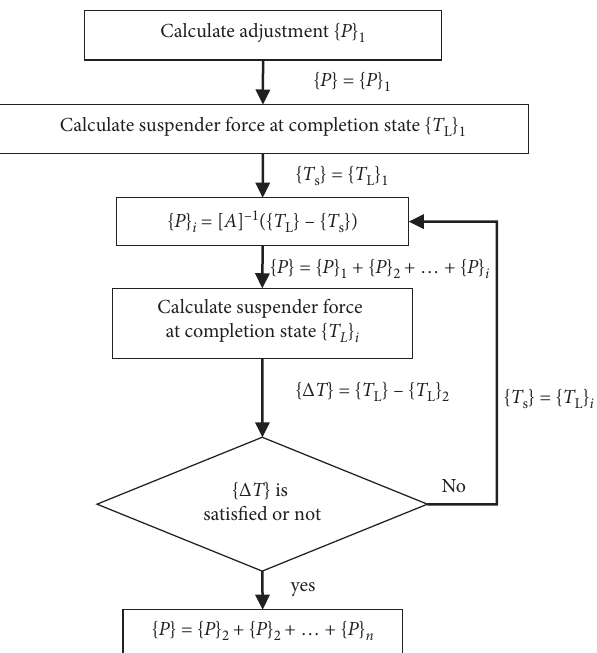
Figure 1: Flowchart of iterative algorithm of suspender tension adjustment.